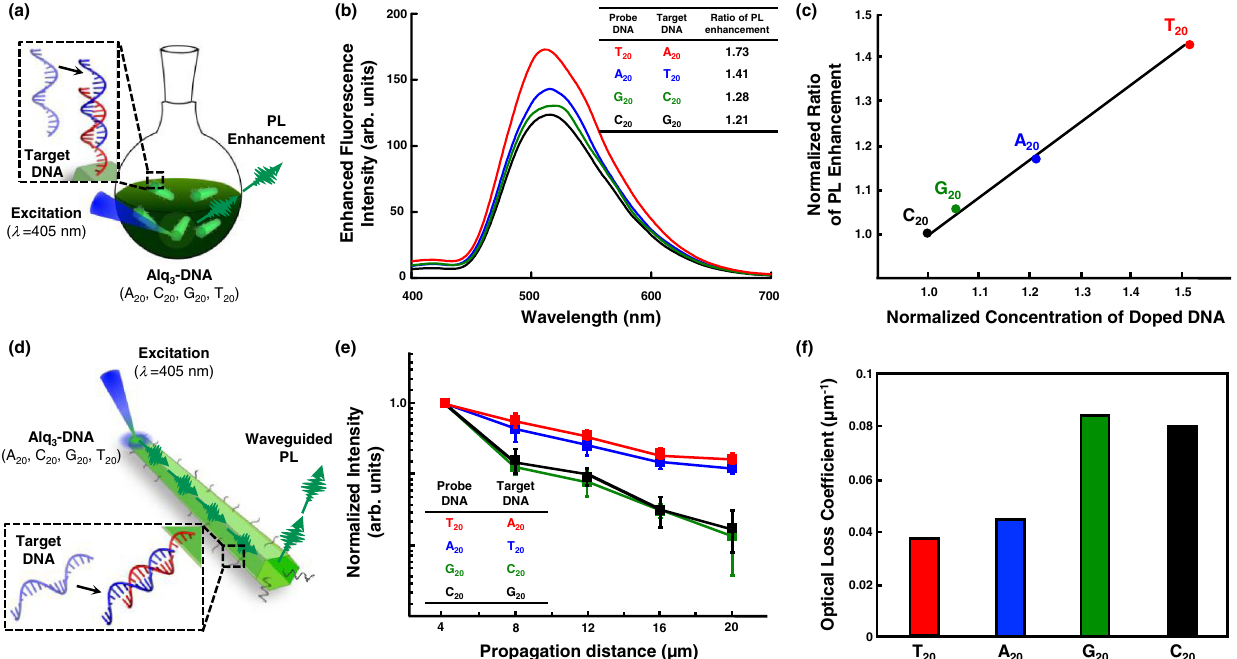
Fig. 4 | Bio-speci fi c photoluminescence and optical waveguide phenomena of Alq 3 microparticlesuponcomplementaryDNA-DNAhybridization.a Schematic illustration for observing bio-recognitive photonics of Alq 3 doped with DNAs. b PL spectra of Alq 3 /DNAs (T 20 , A 20 , G 20 , and C 20 ) after treatment with corresponding complementaryDNAs(excitationat365nm).Theinsetchartrepresentstheratioof PL enhancement compared to PL intensity before complementary DNA treatment (see details in Supplementary Fig. 10). c Normalized ratio of PL enhancement as a function of the normalized concentration of doped DNA-Cy3 molecules.